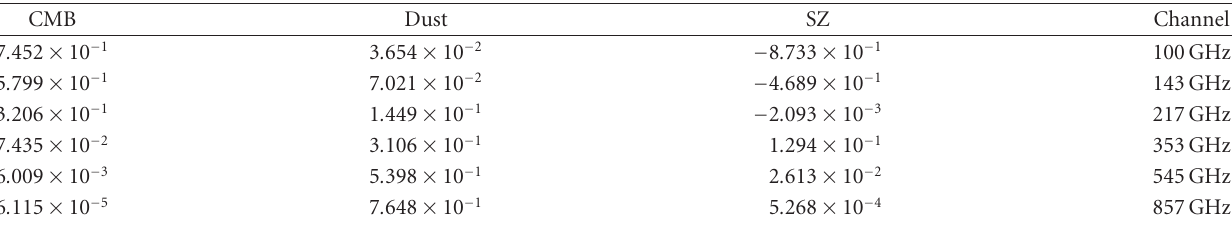
Table 1: Entries of A , the mixing matrix used in our